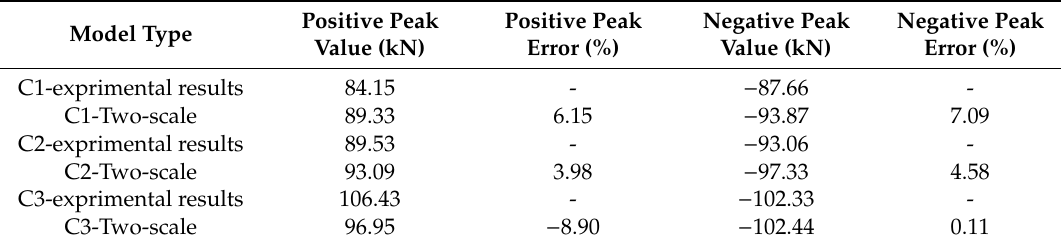
Table 3. Comparison of peak load values.